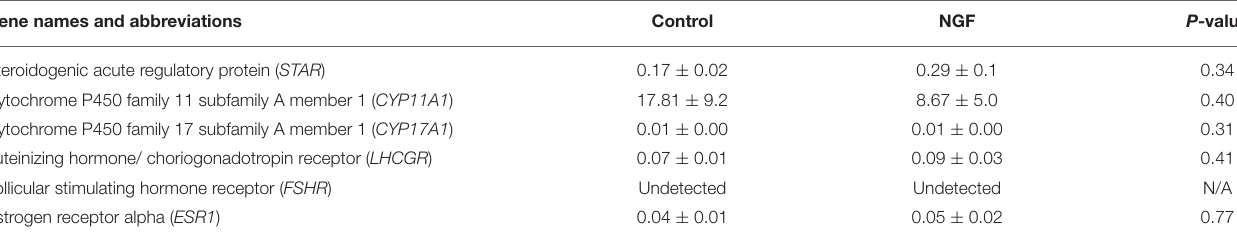
TABLE 2 | Fold change in mRNA expression of gonadotropin receptors, angiogenic enzymes, and steroidogenic enzymes in bovine follicle wall cells preparations treated with 100ng/mL NGF vs. untreated (Control) for